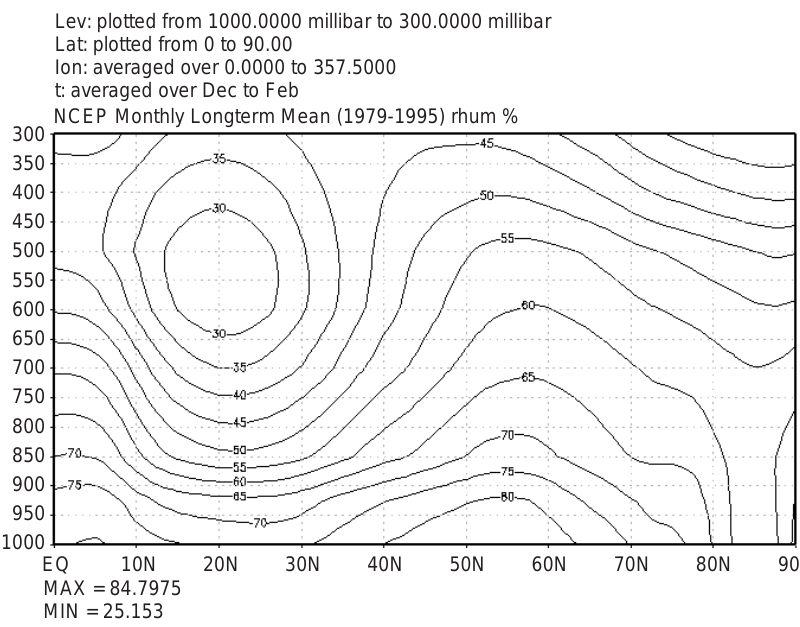
Fig. 2. 1979 to 1995 long-term mean of zonal mean wintertime (DJF) relative humidity as a function of latitude and pressure for the Northern Hemisphere (NCEP reanalysis data). Values given are percentages. contours